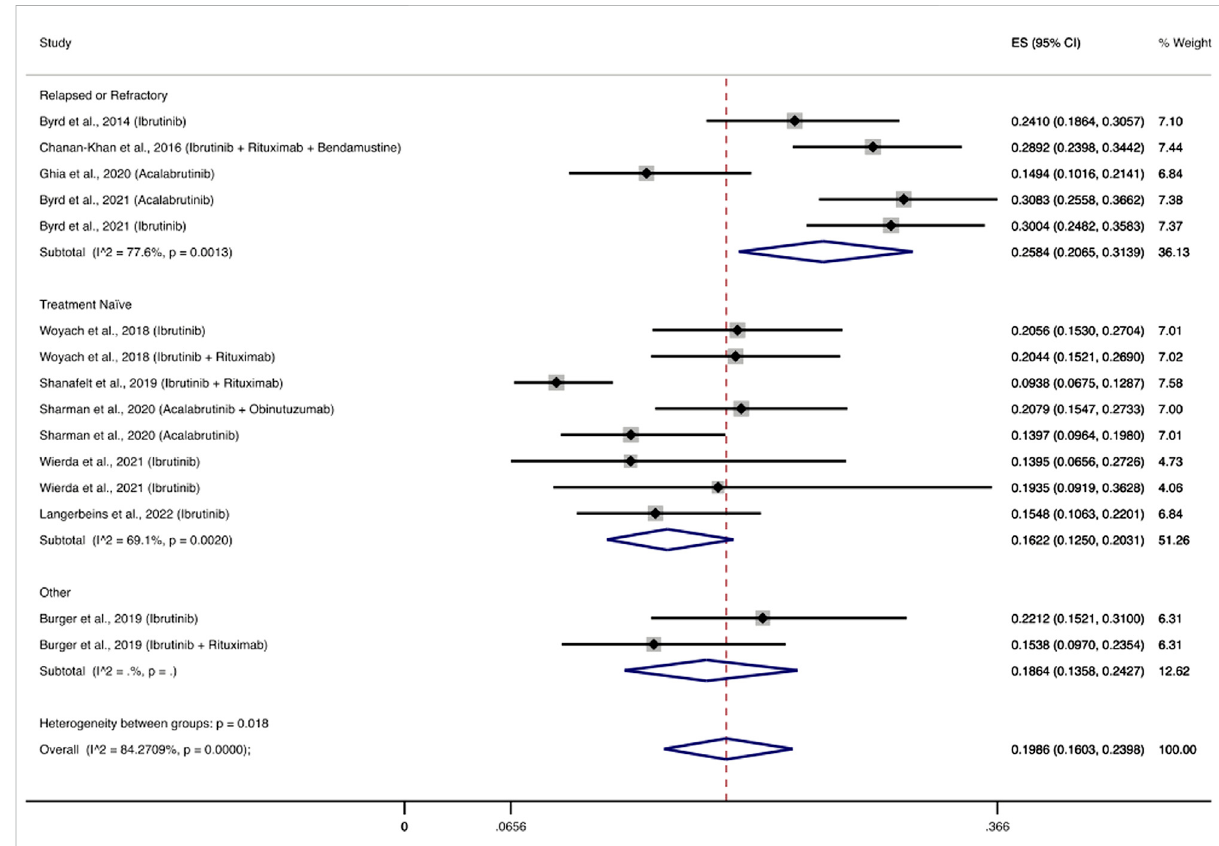
FIGURE 2 Cumulative incidence rate of severe infections BTK inhibitors. Individual and combined estimates of the incidence of severe infections for patients treated with BTK inhibitors with 95% con fi dence intervals. ES: Effect Size (Cumulative